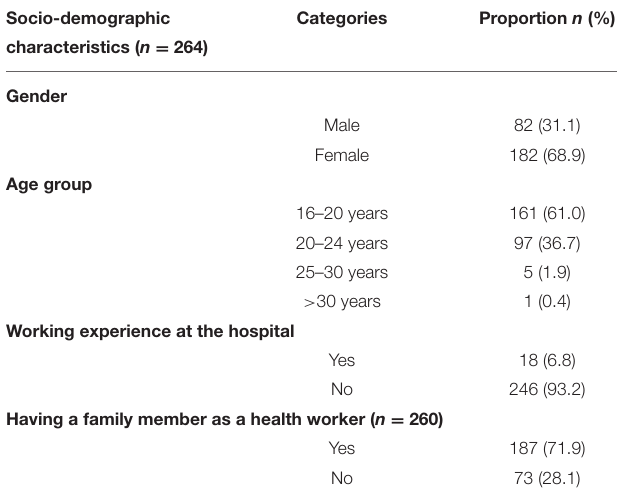
TABLE 1 | Socio-demographic characteristics of participants.